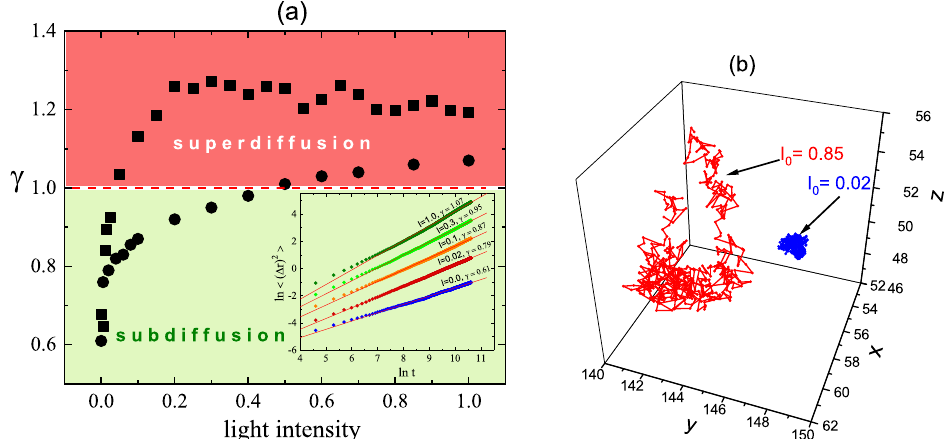
Figure 12. ( a ) Plot of exponent γ as function of the reduced light intensity I 0 for bulk system (circles) and for a single chain (squares). Inset: plots of ln (cid:104) ( ∆ r ) 2 (cid:105) against ln t for bulk system. ( b ) Exemplary trajectories of CM of chains for different illumination intensity, I 0 = 0.85 and I 0 = 0.02. Constant illumination, T = 0.3. Based on